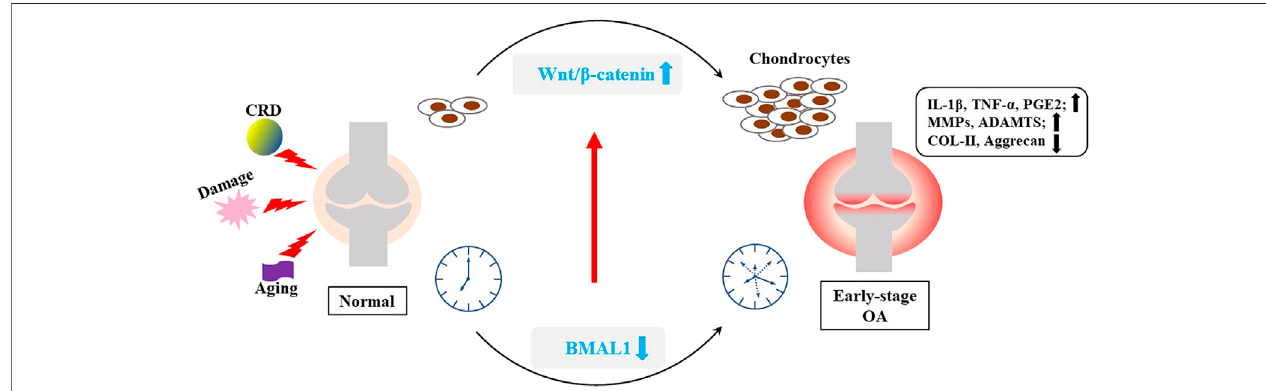
FIGURE 5 | Interaction between BMAL1 and Wnt/ β -catenin. Some internal and external factors, such as mechanical injury, aging and CRD, can stimulate in fl ammation of the knee cartilage, and disrupt the cartilage clock and matrix metabolism.